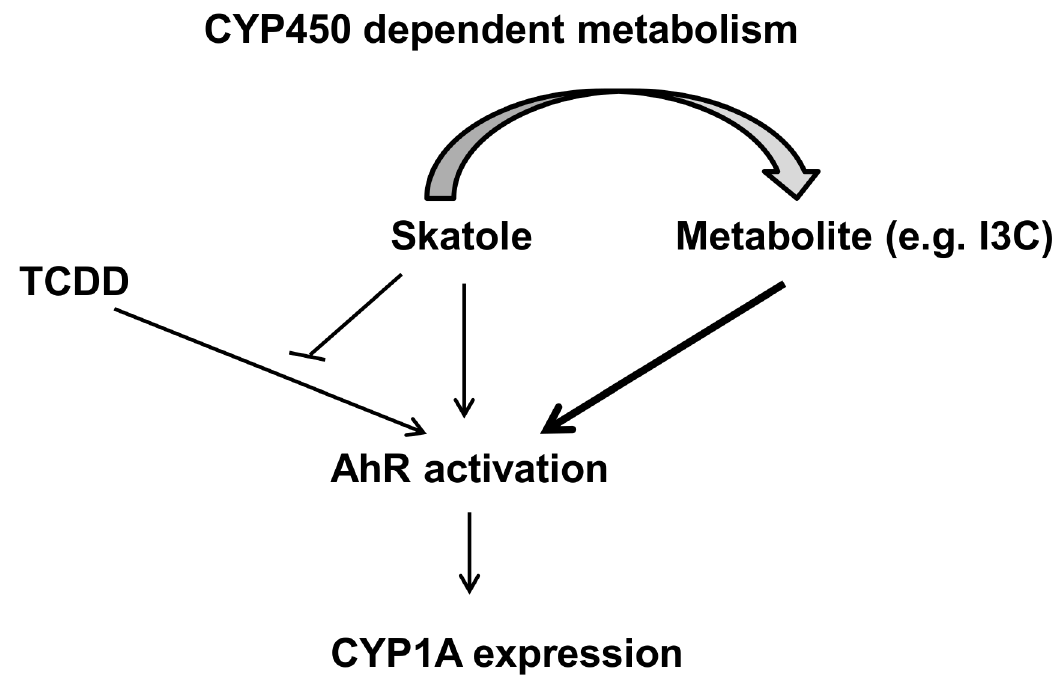
Fig 7. Schematic model of the impact of skatole on AhR activity, as suggested from the findings of this work.